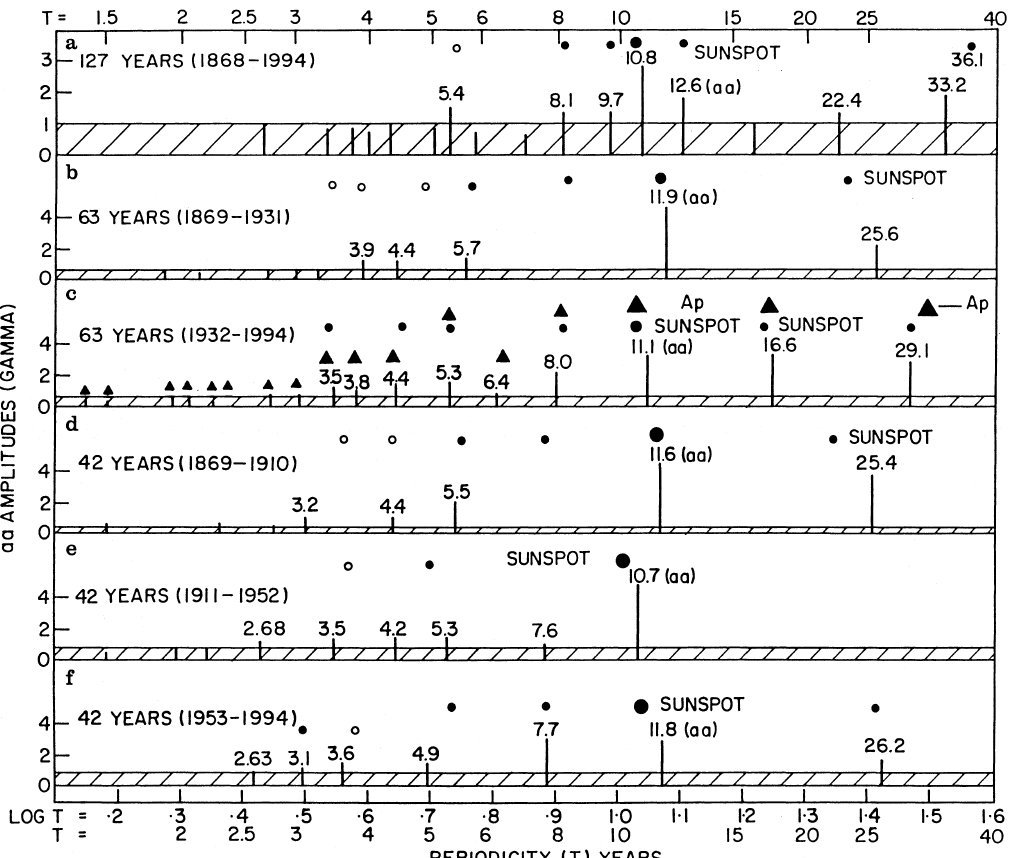
barely significant peaks for sunspots and solid triangles for Ap index. Hatched portions show the 2 (cid:114)